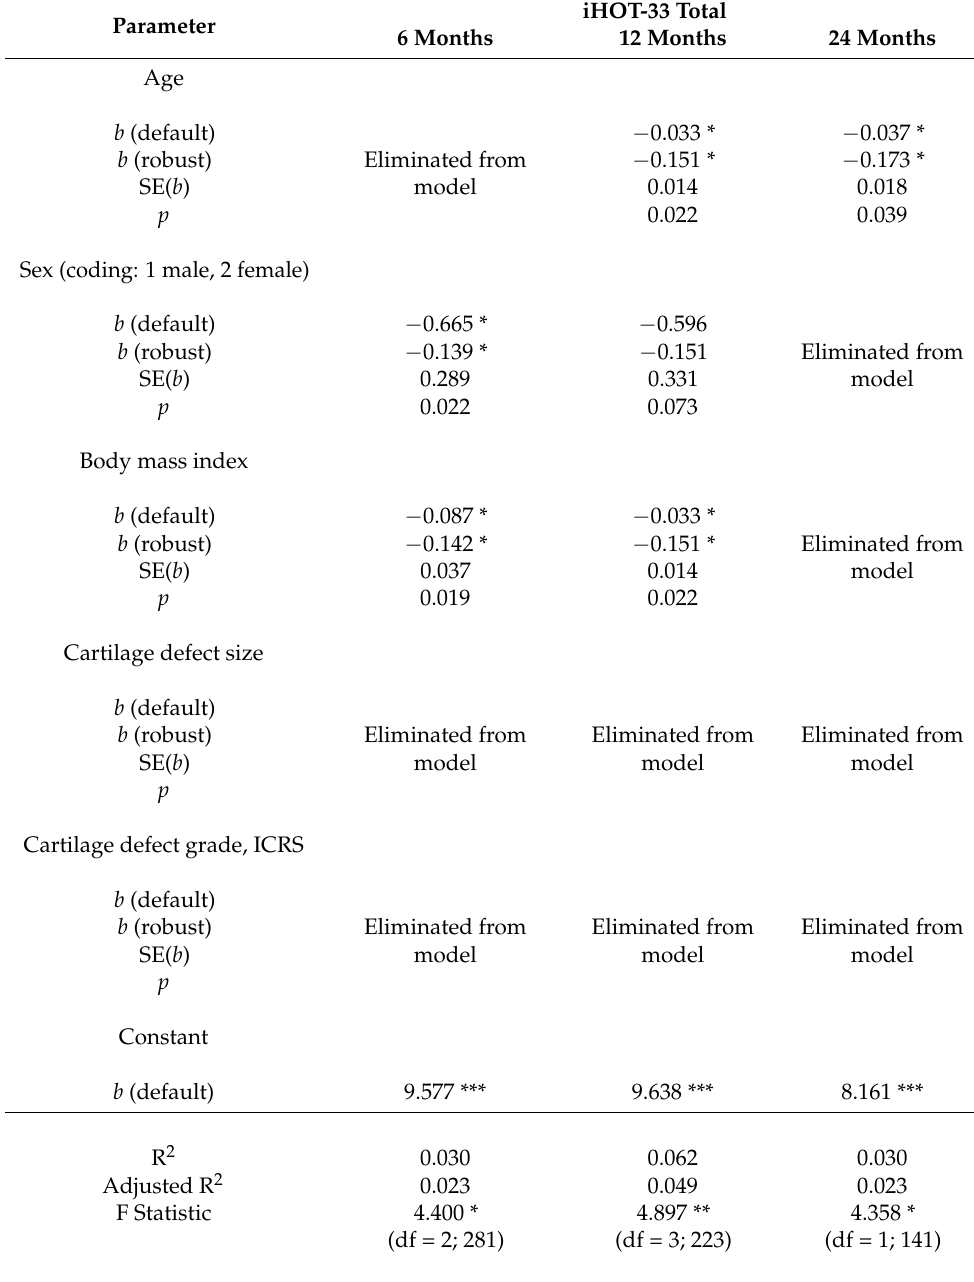
Table 3. Analysis of correlation with postoperative iHOT-33. Multiple regression analysis (backward stepwise elimination) of patient- and defect-specific factors with potential influence on the postopera- tive iHOT-33 total. b , Regression coefficient; SE ( b ), Standard error of b ; p , p -value; ICRS, International Cartilage Repair Society; R 2 , Coefficient of determination; iHOT-33, International Hip Outcome Tool (33 items); Note: * p ≤ 0.05, ** p ≤ 0.01, *** p ≤